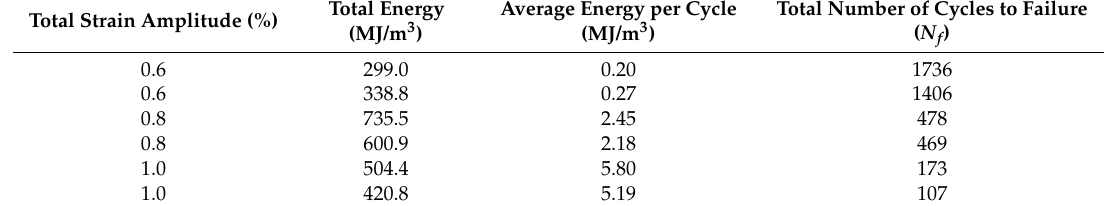
Table 3. Summary of fatigue life and energy dissipated during cyclic deformation [89]. Total Strain Amplitude